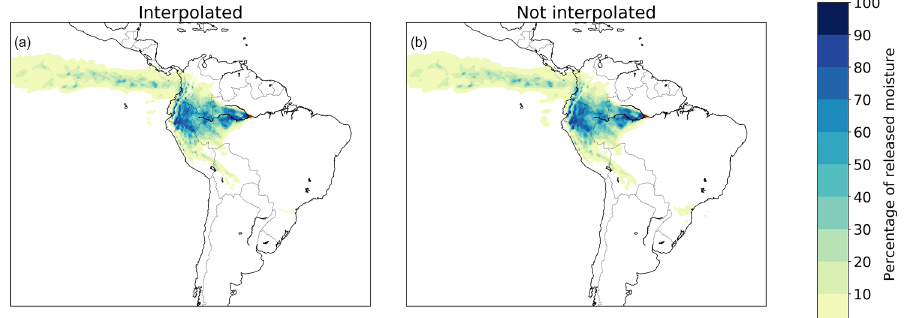
Figure 6. Different footprints of moisture releases from Manaus in July 2012 in a three-dimensional Lagrangian model with and without interpolation of wind speed and directions. (a) Interpolated, with a mean latitudinal moisture flow of 1.5 ◦ in a northerly direction and mean longitudinal flow of 14.4 ◦ in a westerly direction; (b) not interpolated, with a mean latitudinal moisture flow of 1.4 ◦ in a northerly direction and mean longitudinal flow of 14.3 ◦ in a westerly